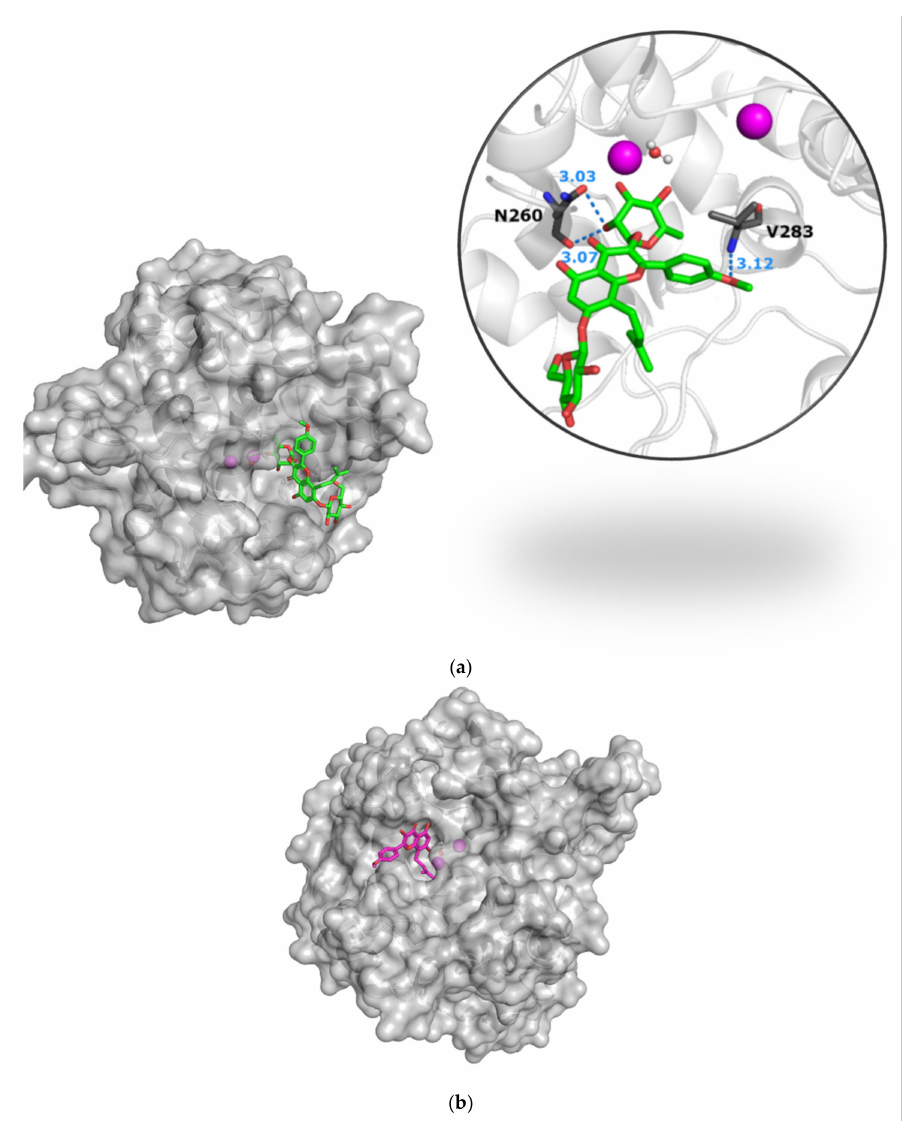
Figure 3. The ligands ( a ) icariin (green) and ( b ) icaritin (magenta) bound to Ab TYR are shown as sticks, while Cu ions (magenta) and the conserved water (red) are shown as spheres. Protein surfaces were rendered with